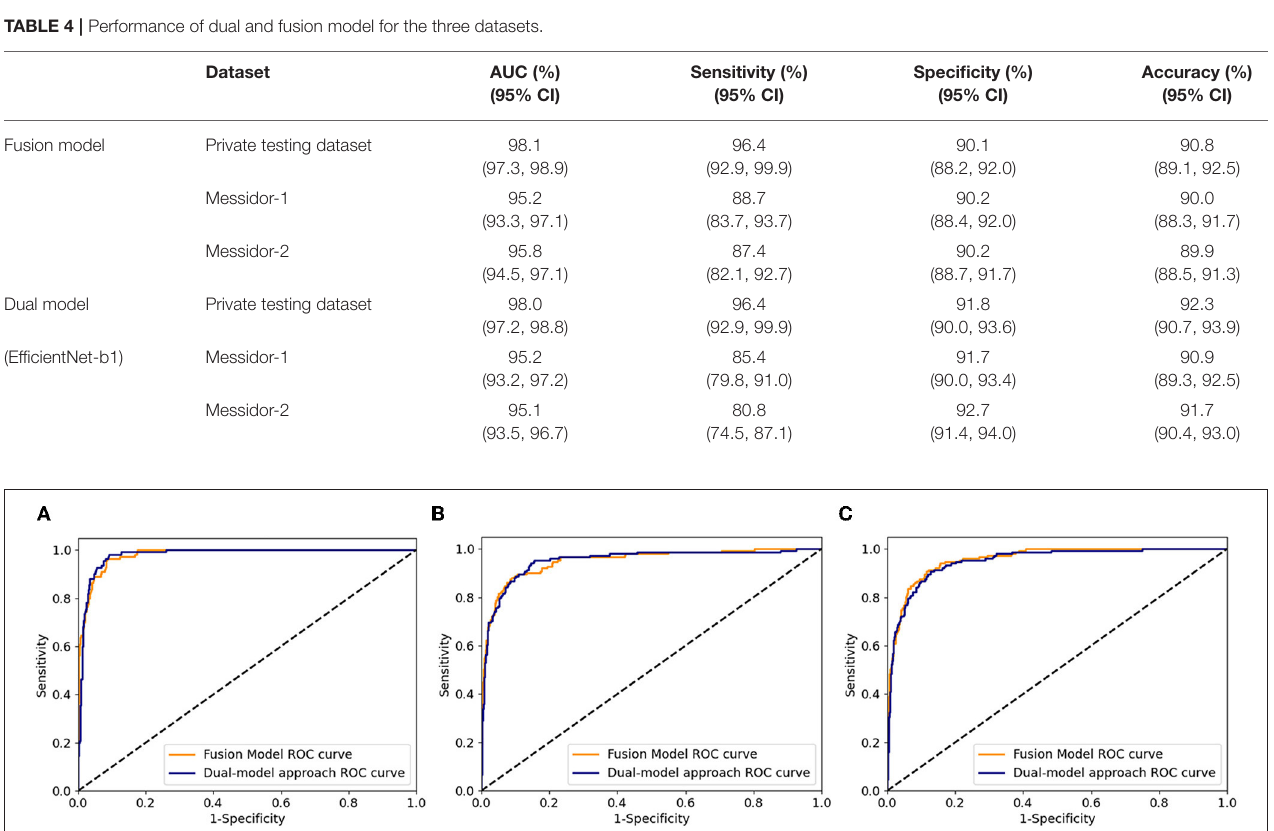
FIGURE 5 | Receiver operating characteristic curves of fusion and dual model for the three datasets. (A) private testing dataset, (B) Messidor-1, and (C) Messidor-2.